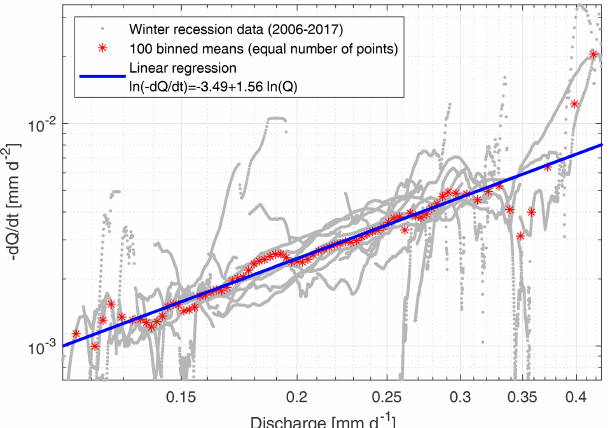
Figure 9. Plot of the smoothed discharge recessions ( − d Q/ d t ) against discharge ( Q ) for all recession periods from 2006 to 2017 (in grey) at the catchment outlet (GS3). Binned averages are shown in red, each bin comprising 1% of the data points. A linear regression (in the logarithmic space) to all binned values smaller than 0.33mmd − 1 is plotted in blue. Axes are in logarithmic scale.